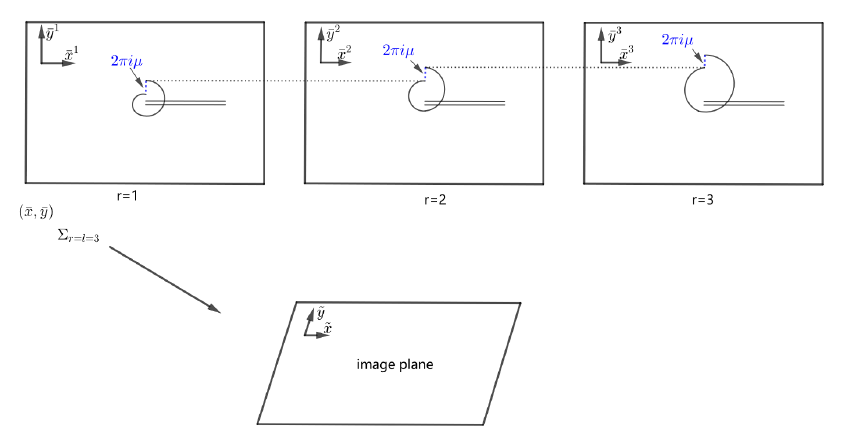
Figure 4 . Three physical sheets in coordinates (¯ x j , ¯ y j ) with j = 1 , 2 , 3 constitute the replicated manifold Σ . When the parameter p in (3.42) is zero, each physical sheet is a reference plane m =3 with identification (¯ x j , ¯ y j ) ∼ (¯ x j e 2 πi , ¯ y j − 2 πiµ ) . The dotted blue lines show the shifts in y direction on each replica sheet, and the dotted black lines help us understand their relations. Under a uniformization map (3.42), the image plane with coordinates (˜ x, ˜ y ) can be chosen as a reference plane, i.e., ˜ y = y where y is defined in (3.12), or a canonical plane, i.e., ˜ y = y 0 where y 0 is defined in (3.13). Here we choose the image plane as a reference plane for